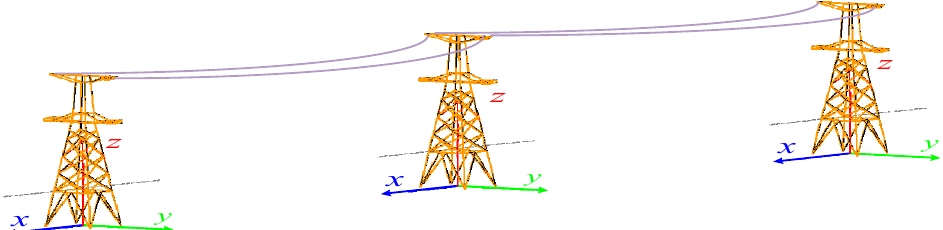
Figure 5. Three-base tower two-span array model considering the sag characteristics of overhead ground wire.